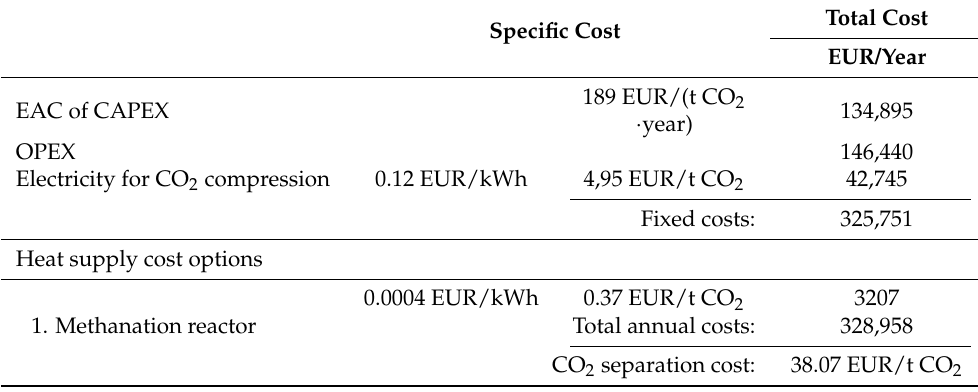
Calculation of CO 2 separation costs for different waste heat utilization options. EAC = equivalent annual costs of